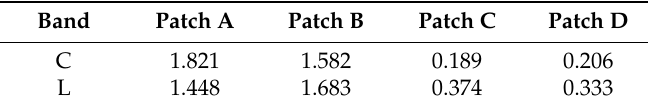
Table 2. Averaged ratio of correlation coefficient for different